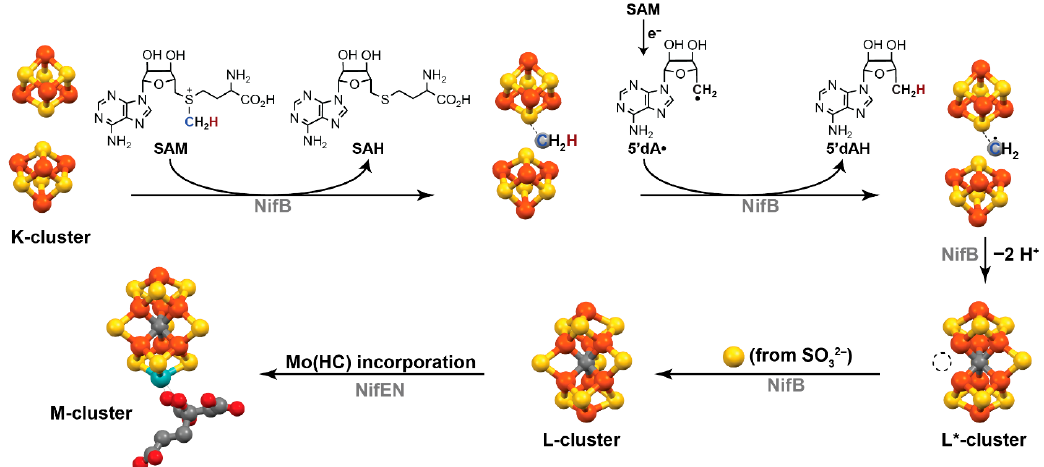
Figure 2. Proposed biosynthetic mechanism for carbide formation, insertion of the ‘9th’ sulfide, and heterometal substitution prior to maturation of the MoFe protein as proposed by Ribbe and Hu [11–13,16–18]. Image adapted with permission from Joseph, C., Cobb, C. R., Rose, M. J. Single-Step Insertion of Sulfides and Thiolate into Iron Carbide-Carbonyl Clusters: Unlocking the Synthetic Door to FeMoco Analogues. Angew. Chemie Int. Ed. 2020 . Accepted, not yet published . Copyright Wiley-VCH GmbH . Reproduced with permission.